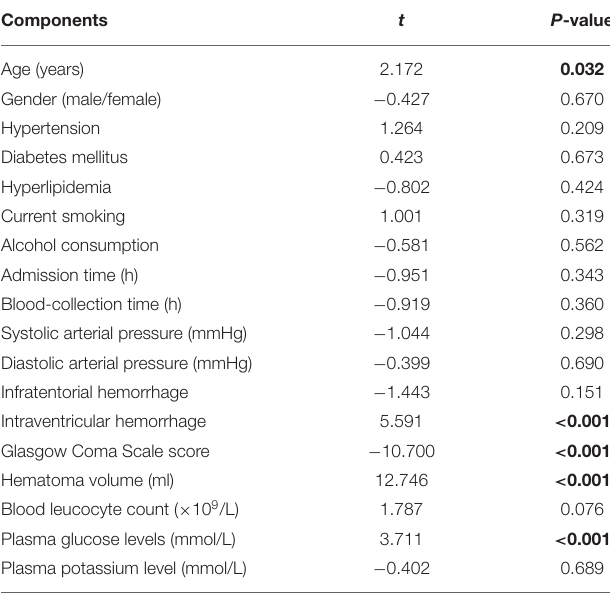
TABLE 3 | Correlations between plasma cellular prion protein levels and other variables using bivariate correlation analysis in intracerebral hemorrhage. Components